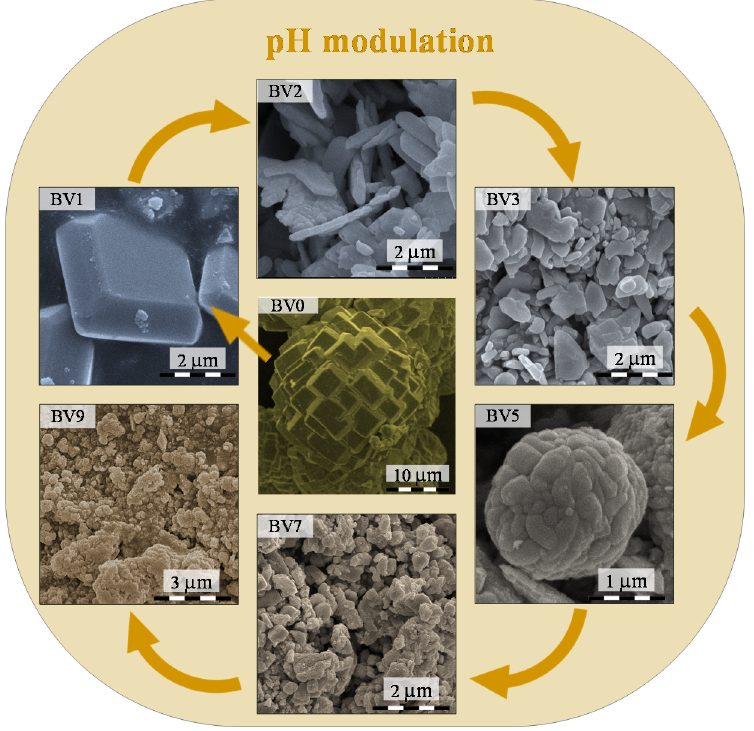
Figure 2. SEM micrographs of the investigated samples, showing the changes in the morphology as the pH of synthesis mixture was adjusted.